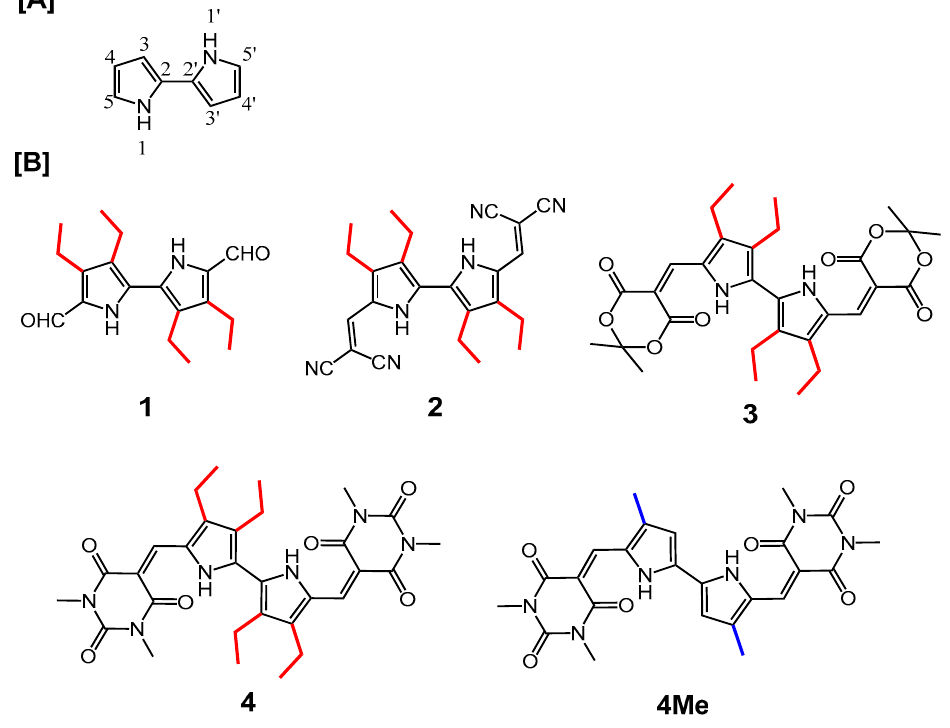
Figure 1. ( A ) Positional numbering system of the bipyrroles; ( B ) Structural formulae of the synthesized divinylbipyrrole compounds 1 – 4 utilized in this study along with the reference compound 4Me .